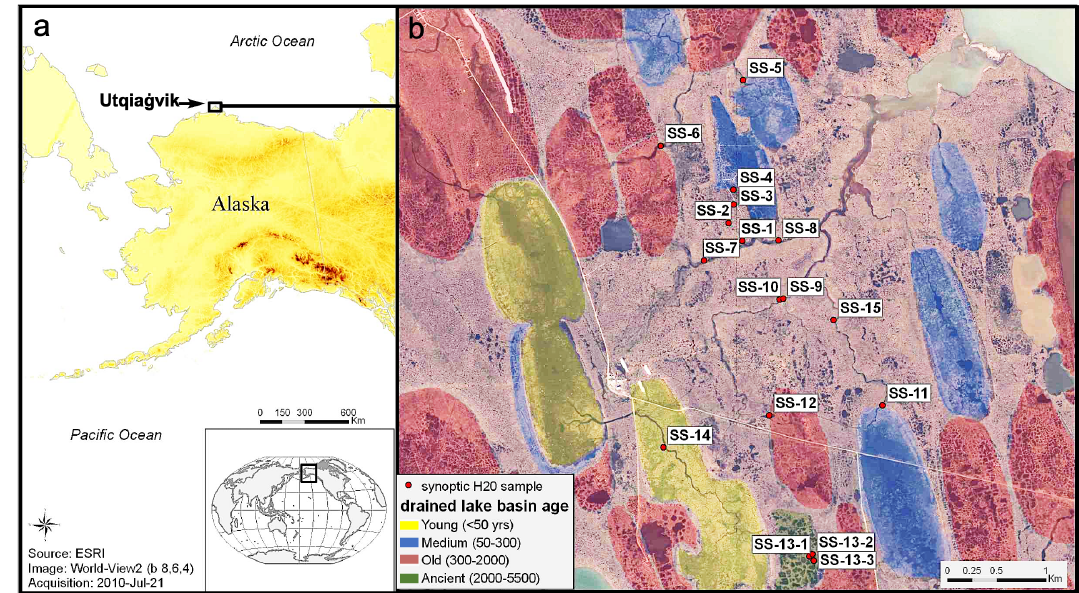
Figure 1. Location of Utqia˙gvik, Alaska, USA (a) , and water sampling sites (b) . Colors in (b) indicate differently aged drained thaw lake basins (DTLBs); see inset legend for ages (Hinkel et al., 2003). Reproduced from Throckmorton et al.